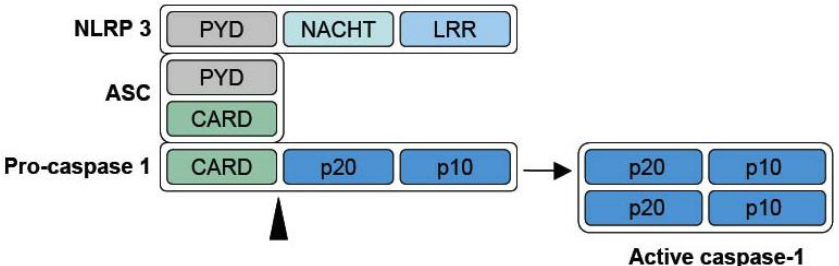
FIGURE 1. The NLRP3 inflammasome. The NLRP3 inflammasome consists of the NLRP3 protein, the ASC adaptor, and pro–caspase-1. Upon stimulation, NLRP3 and ASC adhere via their PYD domains, whereas ASC and caspase-1 adhere via their CARD domains. After autocleavage of the inactive CARD domain from the subunits (p20 and p10), caspase-1 binds to a second monomer, resulting in the active p10/p20